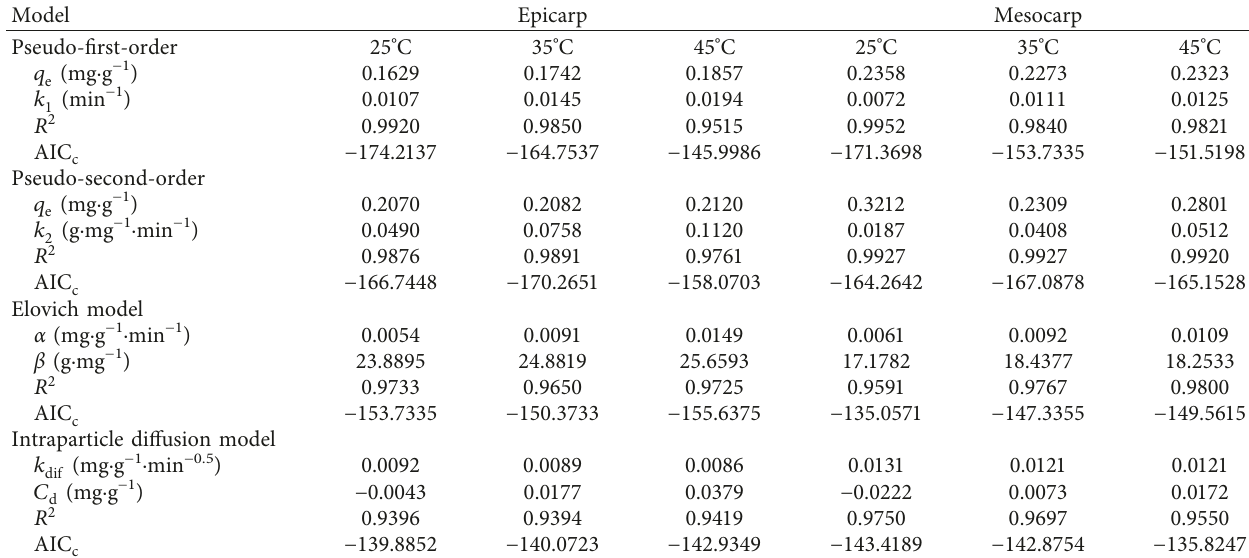
Table 2: Kinetics parameters for adsorption of fluoride ions by epicarp and mesocarp of green coconut.